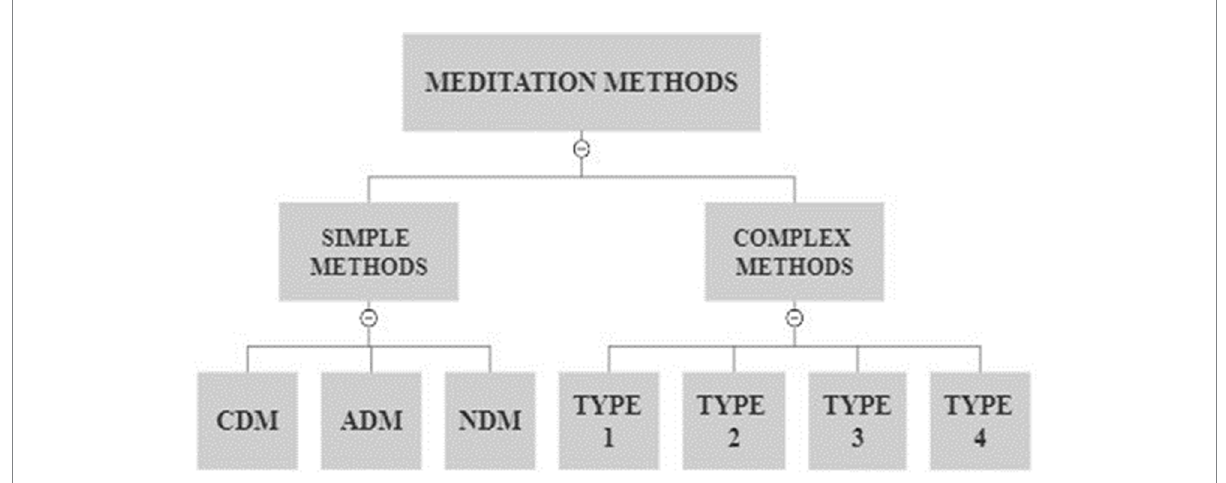
FIGURE 1 Tier 1 and Tier 2 sub-categories of the “Universe” of Meditation